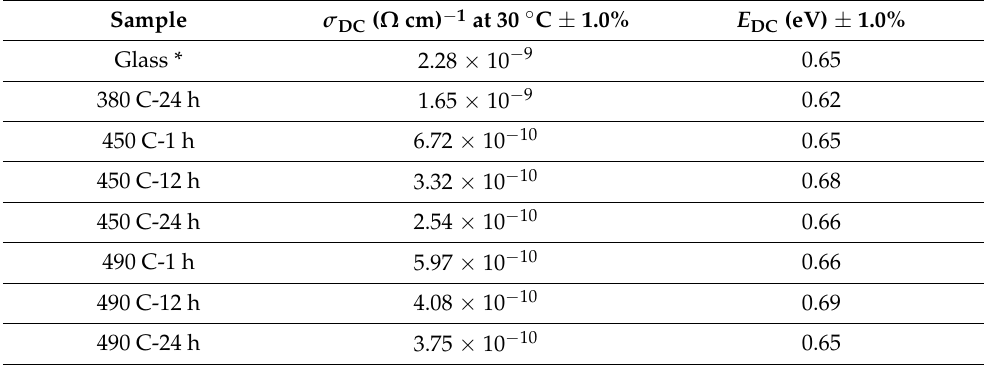
Figure 4. ( a ) Arrhenius plot for glass and glass-ceramics and ( b ) their DC conductivity, σ DC , at 30 °C as a function of heat-treatment temperature and time. The error bars in ( a ) are at most of the order of the symbol size. Table 3. DC conductivity, σ DC , at 30 ◦ C and activation energy, E DC , for parent 40Na 2 O-30MoO 3 -30P 2 O 5 (in mol%) glass and prepared